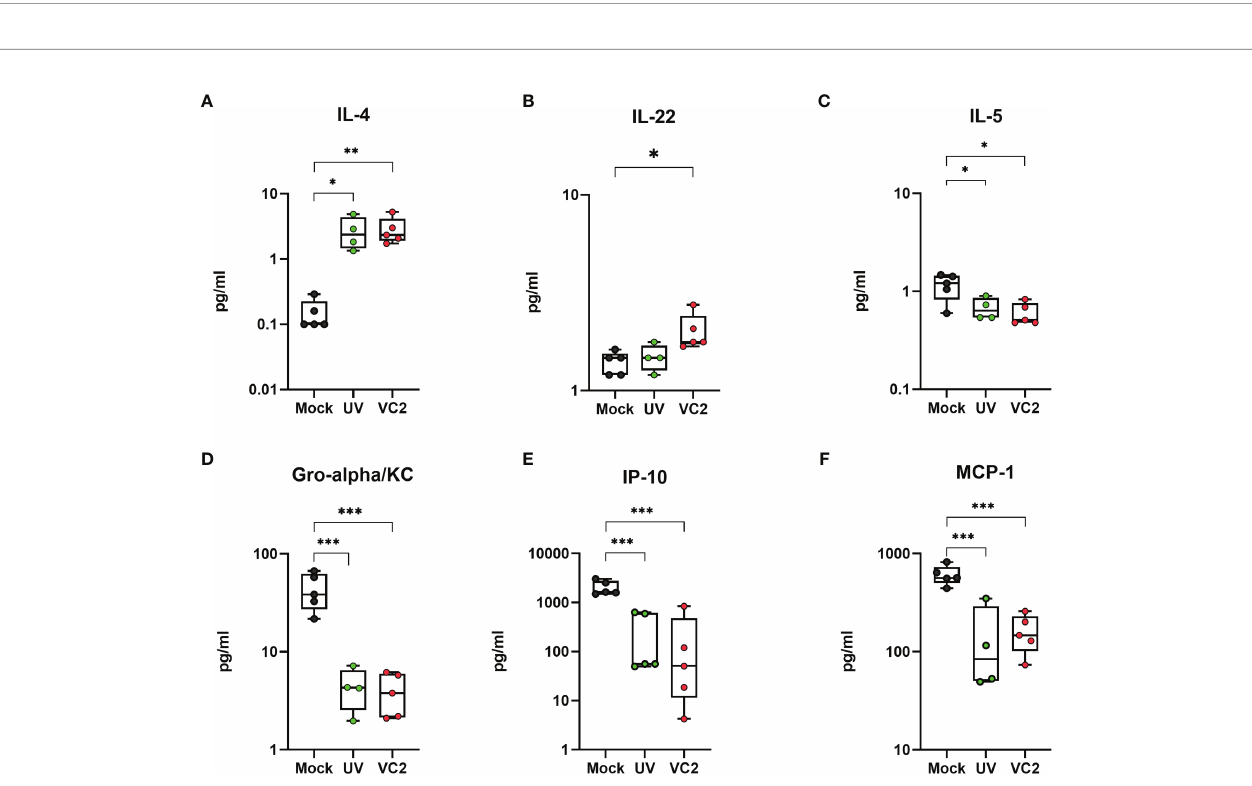
FIGURE 5 | Pro-in fl ammatory and anti-in fl ammatory cytokines and chemokines in whole eye tissues. Cytokine IL-4, IL-22 and IL-5 (A – C) , and chemokine Gro- alpha/KC, IP-10 and MCP-1 (D – F) were measured from homogenized eye samples using the 26 plex immunoassay kit. *<P=0.05, **<P=0.005, ***<P=0.001 using One-Way ANOVA,